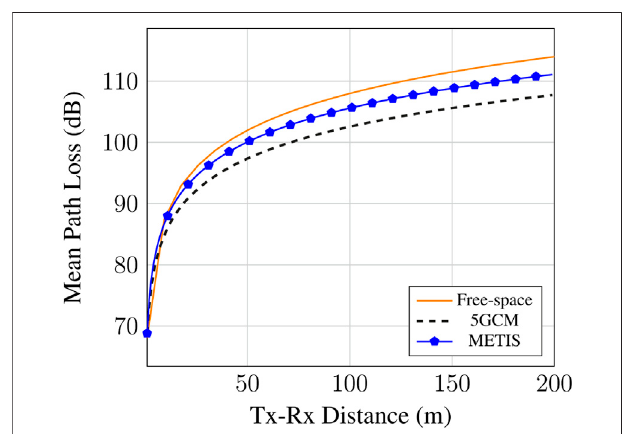
FIGURE 8 | Path loss versus Tx-Rx distance comparison among three different channel models in LOS InH shopping mall